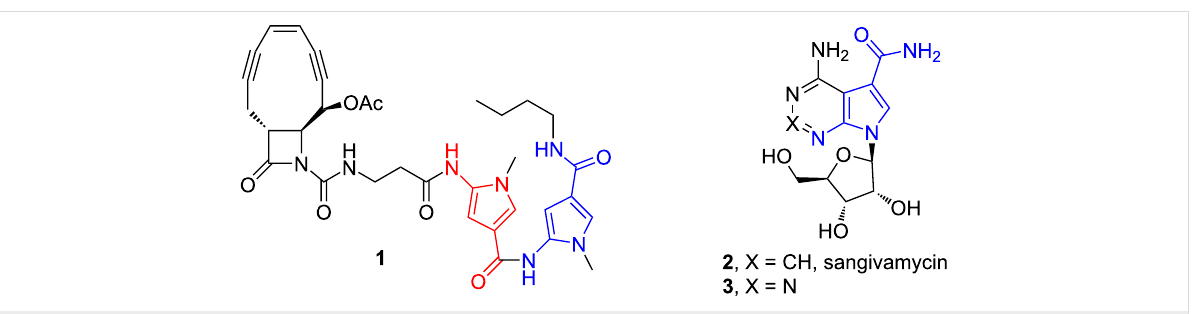
Figure 1: Selected bioactive molecules containing the 5-amino-1 H -pyrrole-3-carboxamide motif.